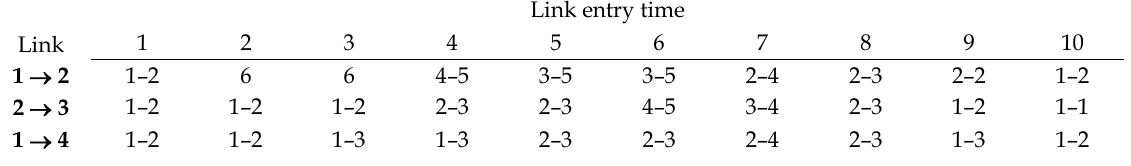
Min–max predicted link traversal time when entering link at given link